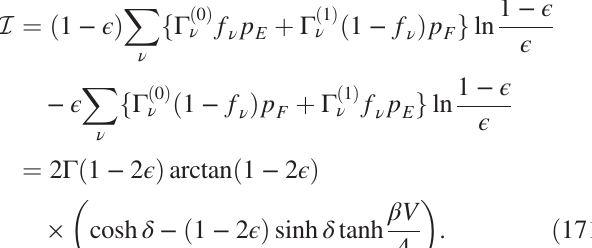
− μ I FIG. 8. Plot of the rate of chemical work β ð μ (thick L R Þ L and solid black line) and of three different dissipations: the total _ Σ one generated by the repeated interaction feedback mechanism [dotted blue line, Eq. (170)], the total one generated by the _ Σ cap capacitive feedback mechanism [dashed green line, Refs. [155,157]], and the “ effective ” estimate obtained in these _ Σ eff [dash- two cases if the demon mechanisms were not known S dotted red line, Eq. (172) and Ref. [151]]. The top row shows − μ these quantities as a function of the bias voltage V ≡ μ for L R two different measurement errors ϵ . The bottom row shows them as a function of the measurement error ϵ ∈ ½ 0 ; 1 = 2 Þ for two different voltages V . The region in which we extract work is shaded in gray. Other parameters are Γ ¼ 1 , δ ¼ ln 2 , β ¼ 0 . 1 , and U ¼ 0 . 1 , and we choose a symmetric configuration of the ϵ ϵ − V= 2 , effectively eliminating V= 2 and μ bias, μ L ¼ S þ R ¼ S the dependence on ϵ in the S